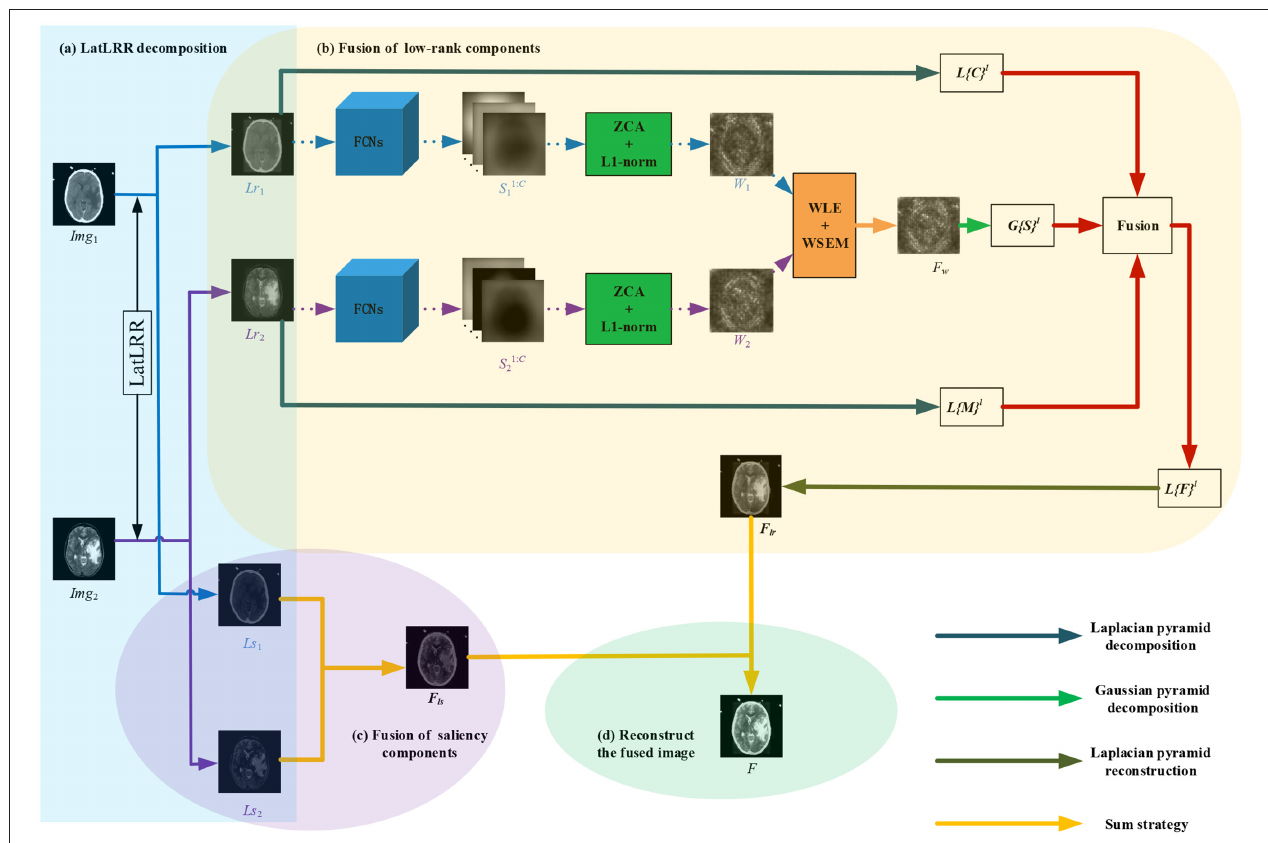
FIGURE 1 | Schematic diagram of the proposed end-to-end frameworks (LatLRR-FCNs). The proposed LatLRR-FCNs enable the fusion image to extract details and preserve energies from paired sources. It is composed of four parts: (a) LatLRR decomposition, (b) fusion of low-rank components, (c) fusion of saliency components, and (d) reconstruction of fused image. Img 1 and Img 2 are the source medical images, Lr 1 and Lr 2 are the low-rank components of Img 1 and Img 2 , Ls 1 and Ls 2 are the saliency components of Img 1 and Img 2 , S 11 : C and S 21 : C are the score maps, W 1 and W 1 are the initial weight maps of Lr 1 and Lr 2 , and the final fused weight map is F